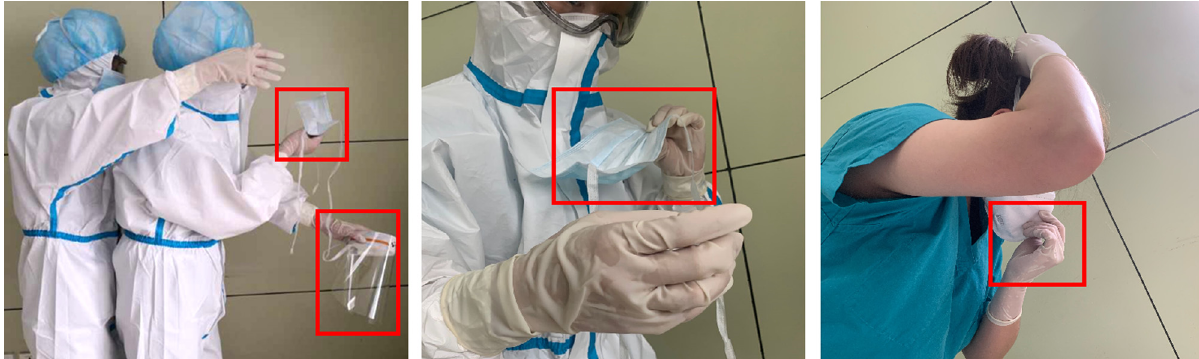
Figure 3: A representative image showing that incorrect methods have a high risk to contaminate surgical mask, the disposable coverall suit, and face shield.